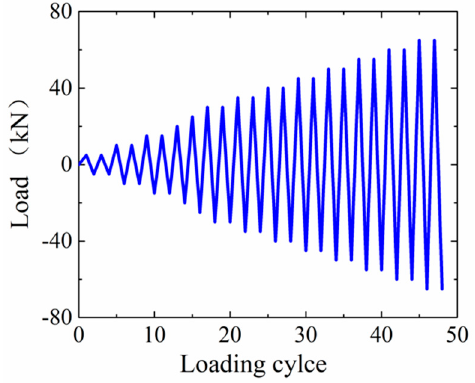
Figure 5. The loading scheme for the cycle test.